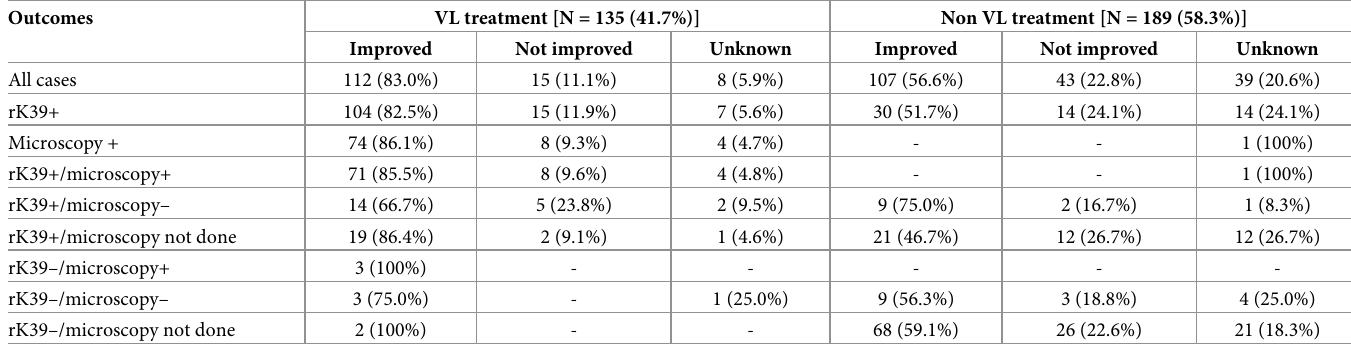
Table 3. Outcomes stratified by VL laboratory diagnosis result status and VL treatment